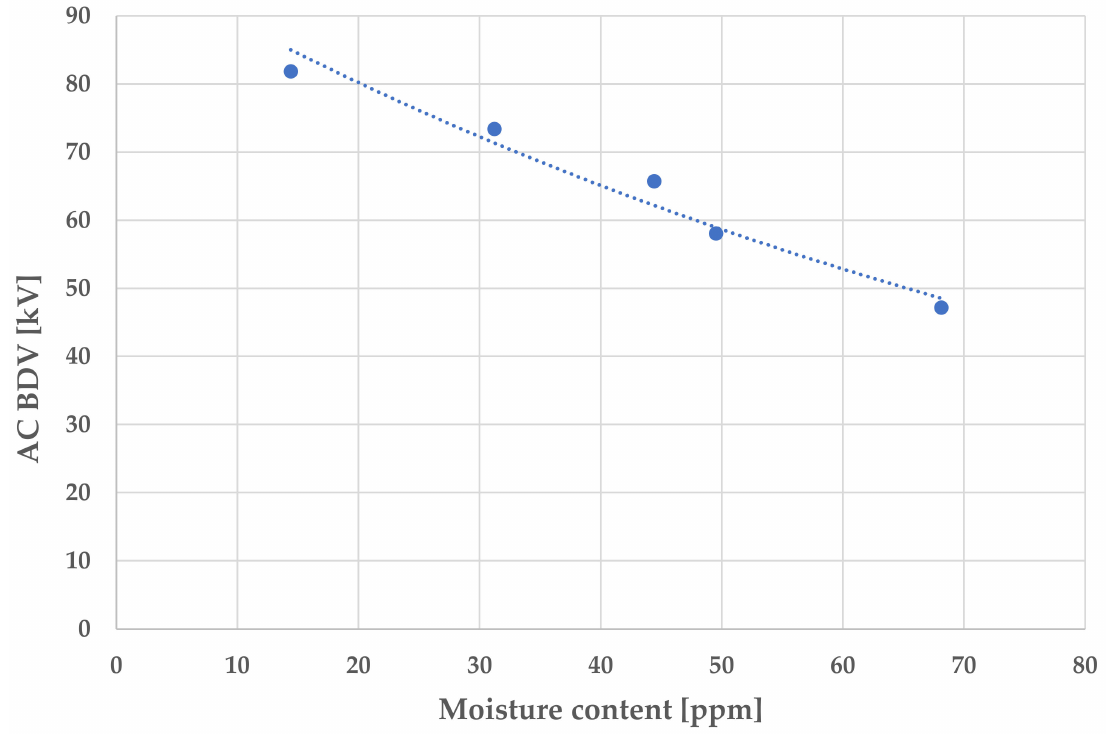
Figure 1. Influence of water content on the AC BDV of mineral oil, based on